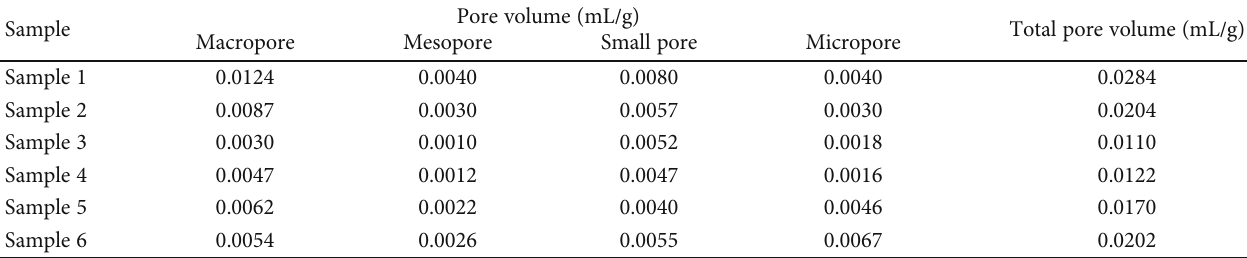
Table 2: Joint characterization results of pore volume.